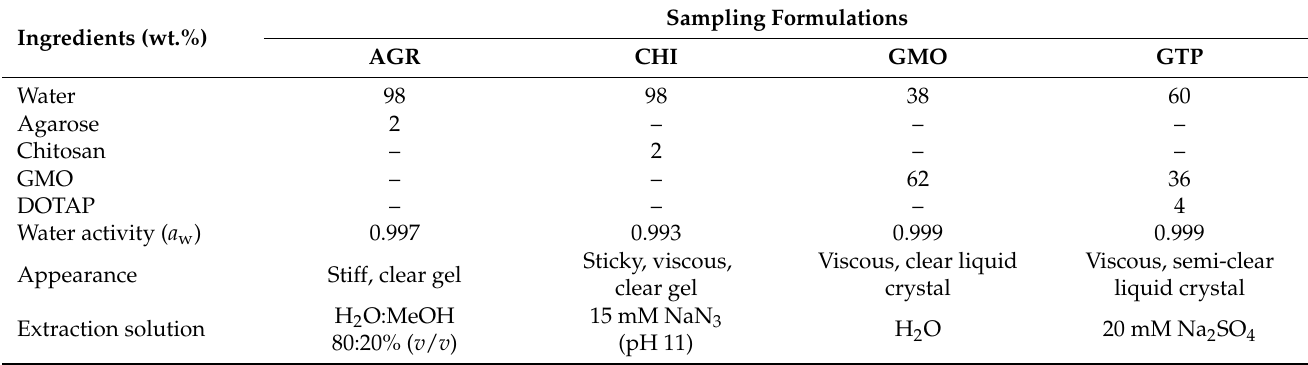
Table 1. Composition of sampling